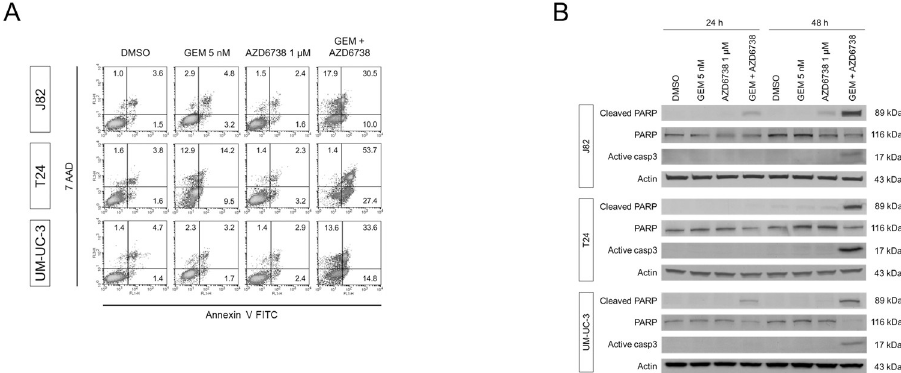
Fig 3. Induction of apoptosis after treatment with gemcitabine and/or AZD6738. (A) Flow cytometric analysis of bladder cancer cells with the indicated treatment after combined staining with Annexin V and 7-amino-actinomycin D (7AAD). Percentages of viable (lower left), early (lower right), or late (upper right) apoptotic and necrotic (upper left) cells subsequent to indicated treatments. (B) PARP cleavage and active caspase 3 48 h after treatment assessed by western blot